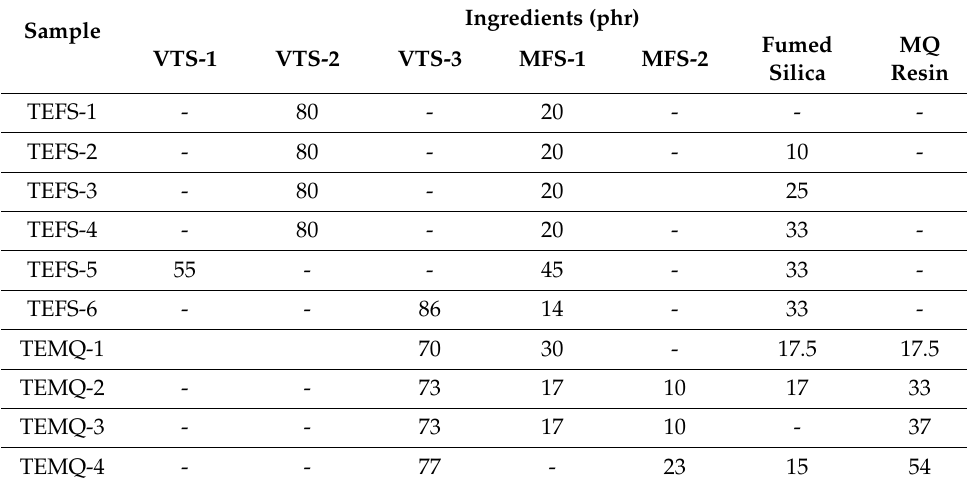
Scheme 1. Chemical structures of UV-curable silicone components. ( a ) Siloxane monomers; vinyl terminated polydimethyl- siloxane (VTS) and mercapto functionalized polydimethylsiloxane (MFS). ( b ) Reinforcing fillers; fumed silica and MQ resin, derived from tetraorthosilicate. ( c ) Photoinitiator packages consisting of radical-generator (ITX + EHDA), photo-absorber (BTA), and radical-inhibitor (MEHQ). Table 1. Composition of PDMS-resin formulations. TEFS and TEMQ refer to resins reinforced with fumed silica and MQ resin, respectively. phr is the mass part of filler per hundred mass parts of rubber (i.e., VTS +